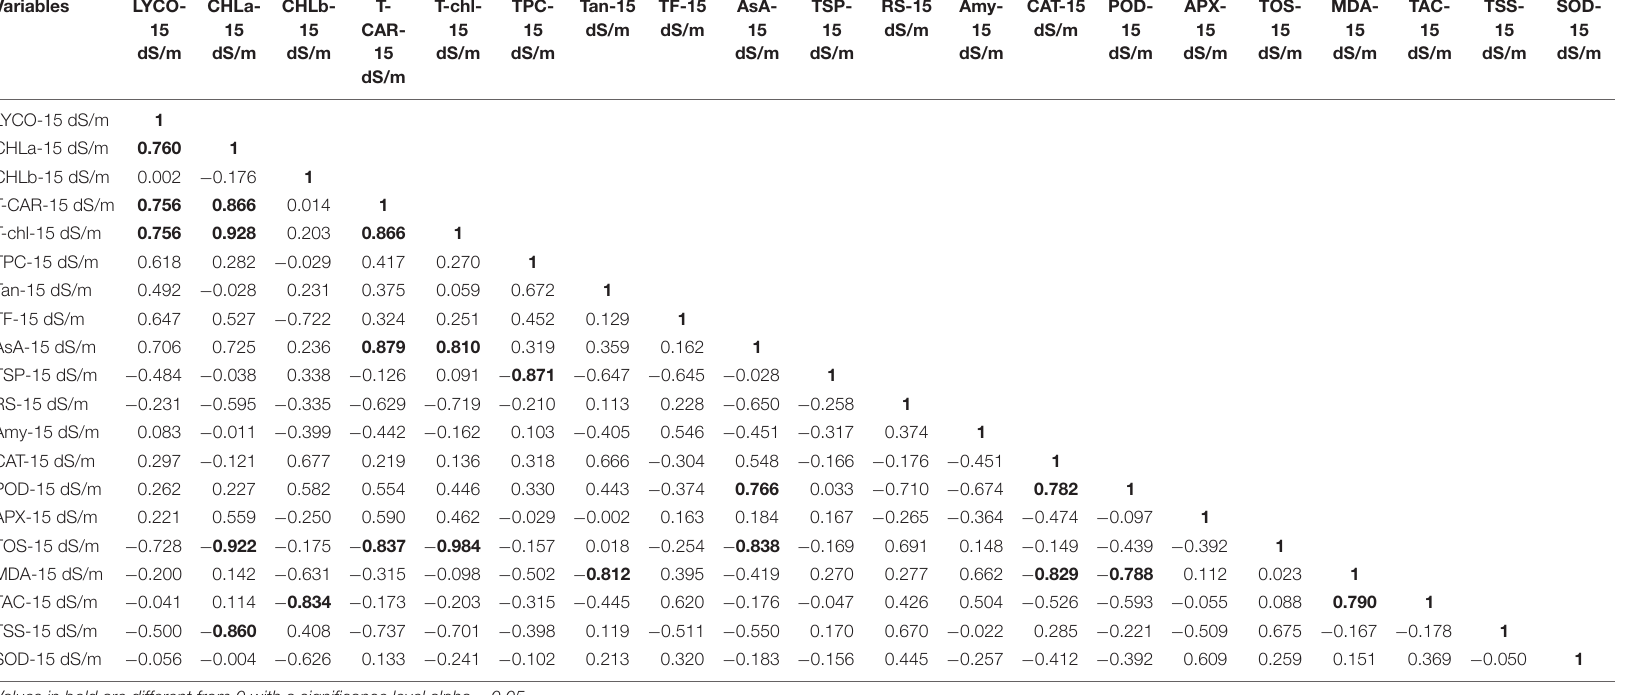
Values in bold are different from 0 with a significance level alpha =